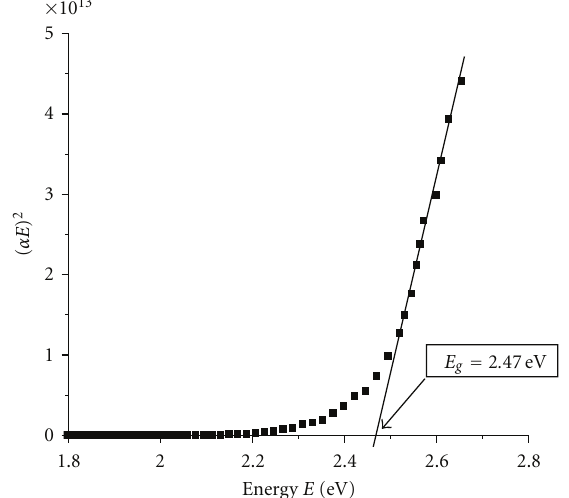
Figure 6: Determination of the gap energy of undoped In 2 S 3 from the curve ( α E ) 2 versus pump beam energy E